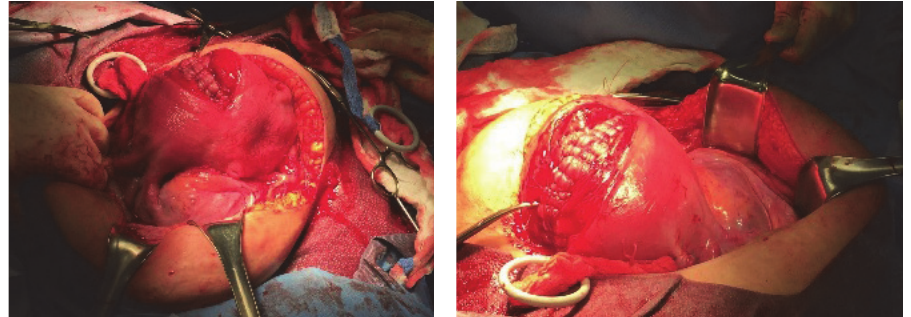
Figure 1: Intraoperative images after hysterotomy closure demonstrating hypervascularity of the lower uterine segment with ballooning of the right broad